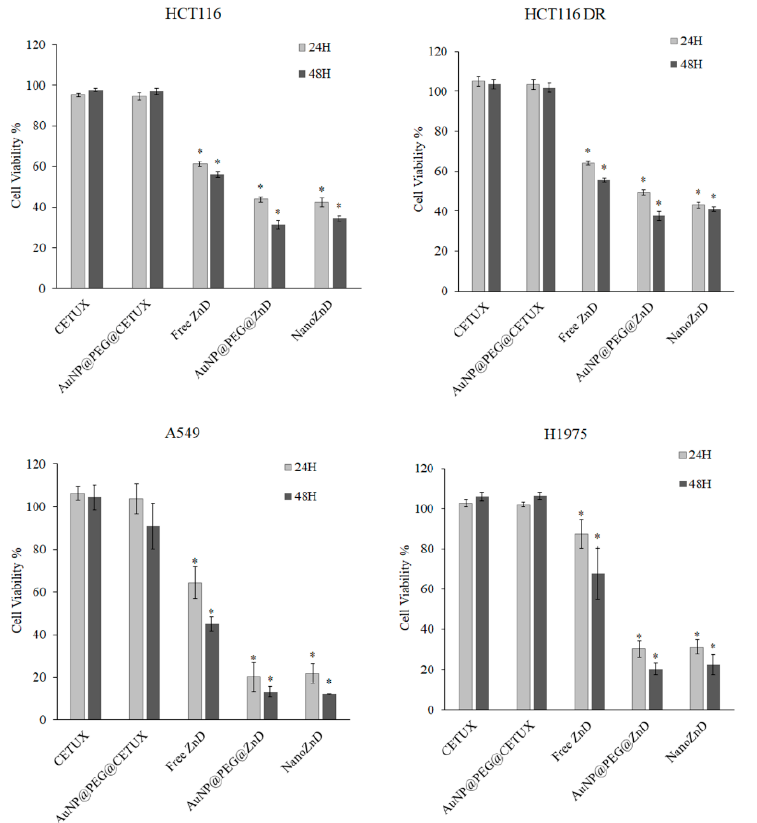
Figure 5. Cell viability assessment of the nanoconjugates in HCT116 and HCT116 DR cell lines after 24 and 48 h of incubation. Antiproliferative activities were assessed and compared to free ZnD (at its IC 50 at 48 h) for each cell line (Table 1). Data are represented as mean ± SEM of at least three independent experiments. Cell viability was normalized to the control group without nanoparticle systems/compound. * p < 0.05 compared to control.